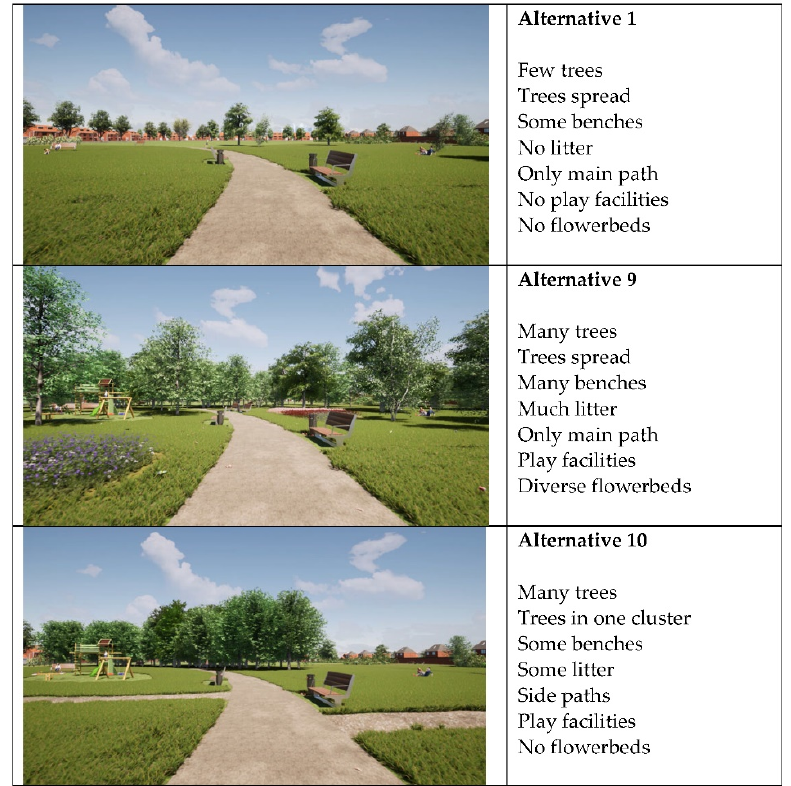
Figure 1. Screenshots of different park alternatives with varied attributes.